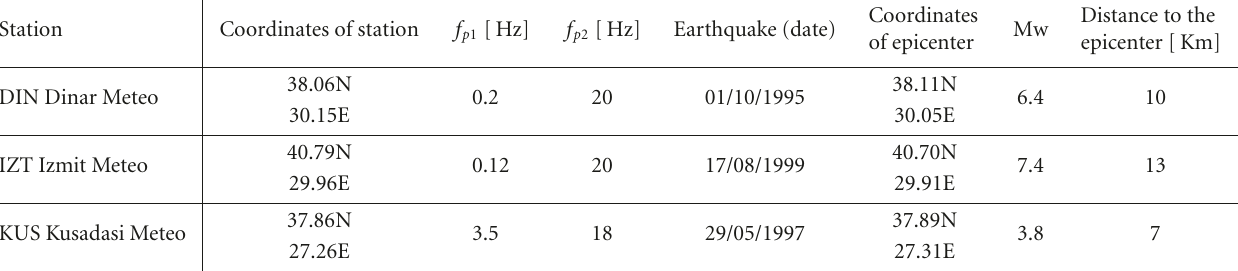
Table 1: Stations and data under investigation.